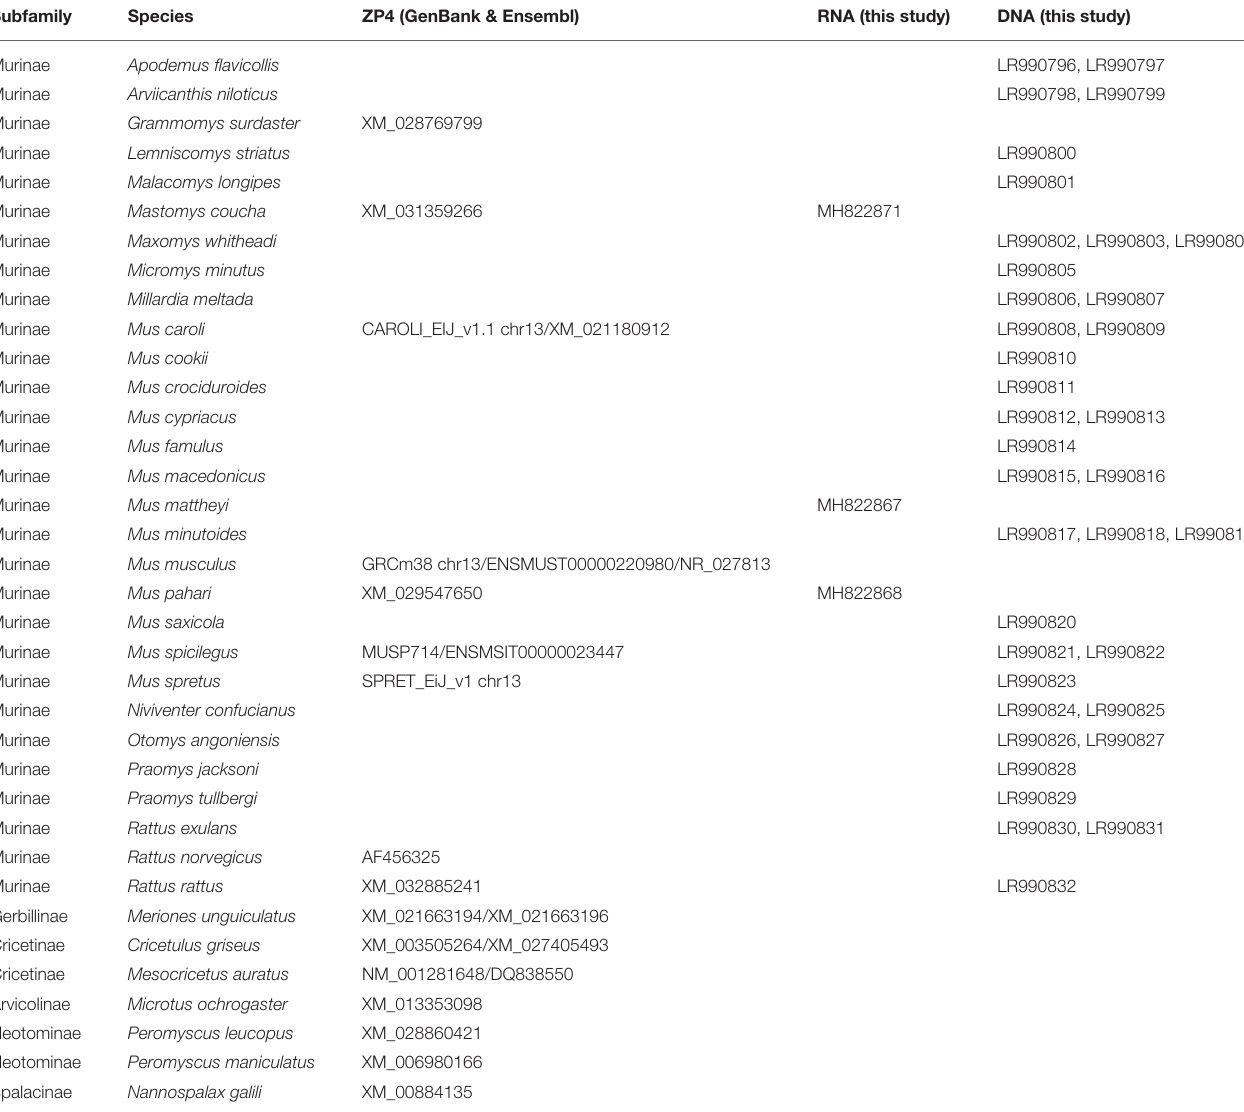
TABLE 1 | Muroid species and accession numbers of the sequences used for the phylogenetic study of the Zp4 gene. Subfamily Species ZP4 (GenBank & Ensembl) RNA (this study) DNA (this